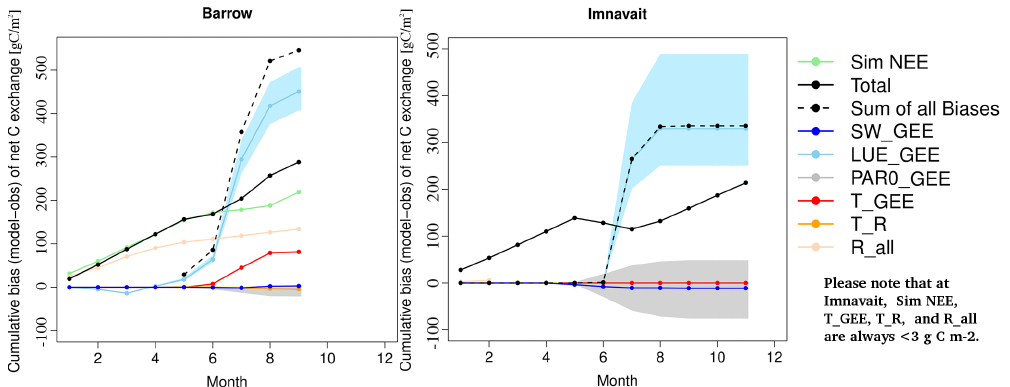
Figure 2. Cumulative monthly bias in PolarVPRM estimates of net C exchange at Barrow (left) and Imnavait (right), relative to eddy covariance observations at these sites. Errors in GEE are designated as being due to the associations between GEE and downward shortwave radiation (SW_GEE), GEE and light-use efficiency (LUE_GEE), and of the parameter describing the association between GEE and PAR0 (PAR0_GEE). Shaded areas surrounding (PAR0_GEE) and (LUE_GEE) represent the range of biases possible from the determination of PAR0 and λ from eddy covariance observations. Total biases in temperature and GEE (T_GEE), and between temperature and respiration (T_R) are also described, along with the total biases in respiration (R_all) and NEE. Comparisons are shown for the range of months for which eddy covariance observations were acquired at Barrow in 2001 (January–September), and at Imnavait in 2008 (February–October).